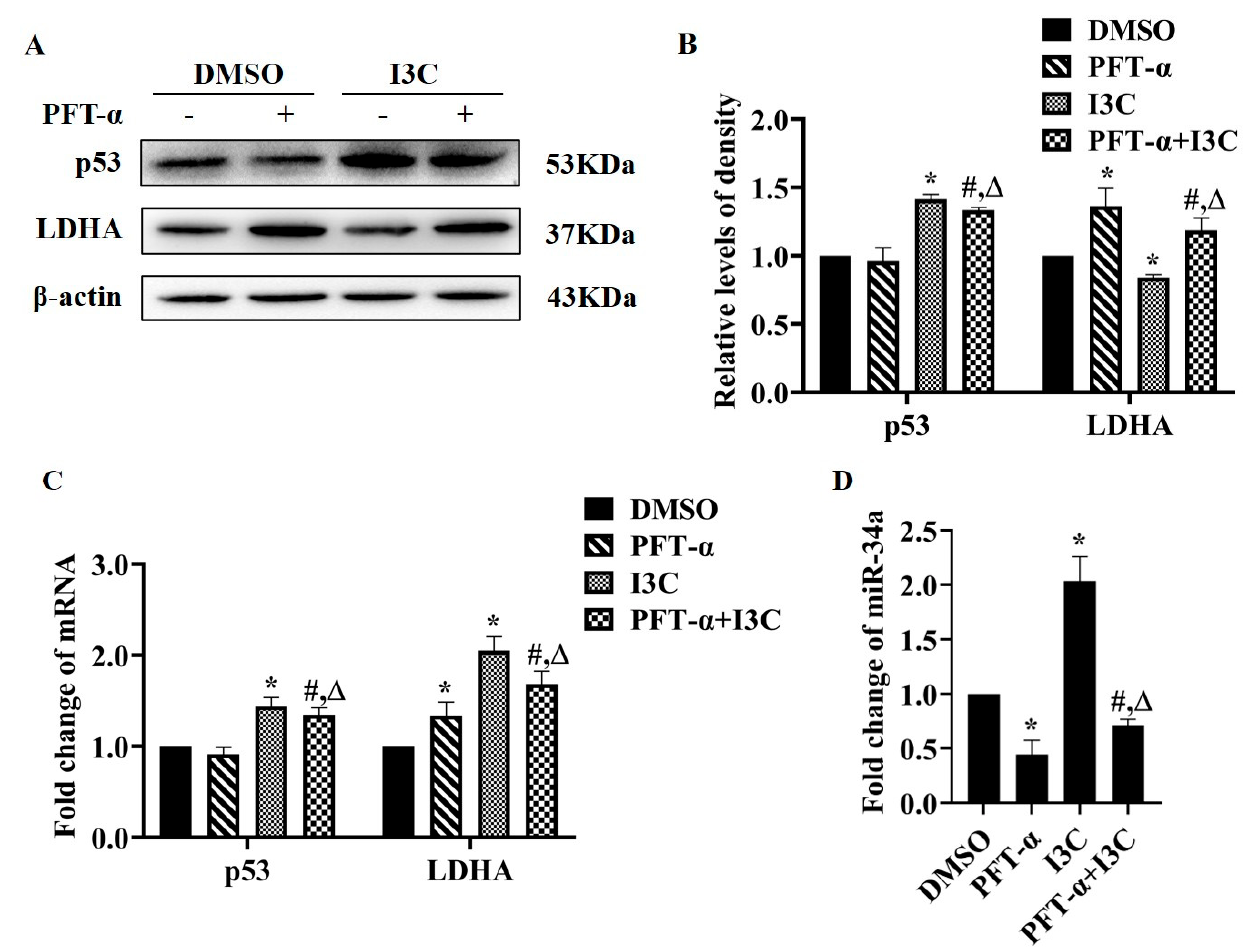
Figure 5. The effects of I3C and p53 inhibitor (PFT- α ) on the expression levels of miR-34a and LDHA. ( A ) The effect on the protein expression of p53 and LDHA; ( B ) Densitometric analysis for blots shown in ( A ); ( C ) Measurement of the mRNA levels of p53 and LDHA; ( D ) The effect on the expression of miR-34a. * p < 0.05 vs. DMSO, # p < 0.05 vs. PFT- α , Δ p < 0.05 vs. I3C.